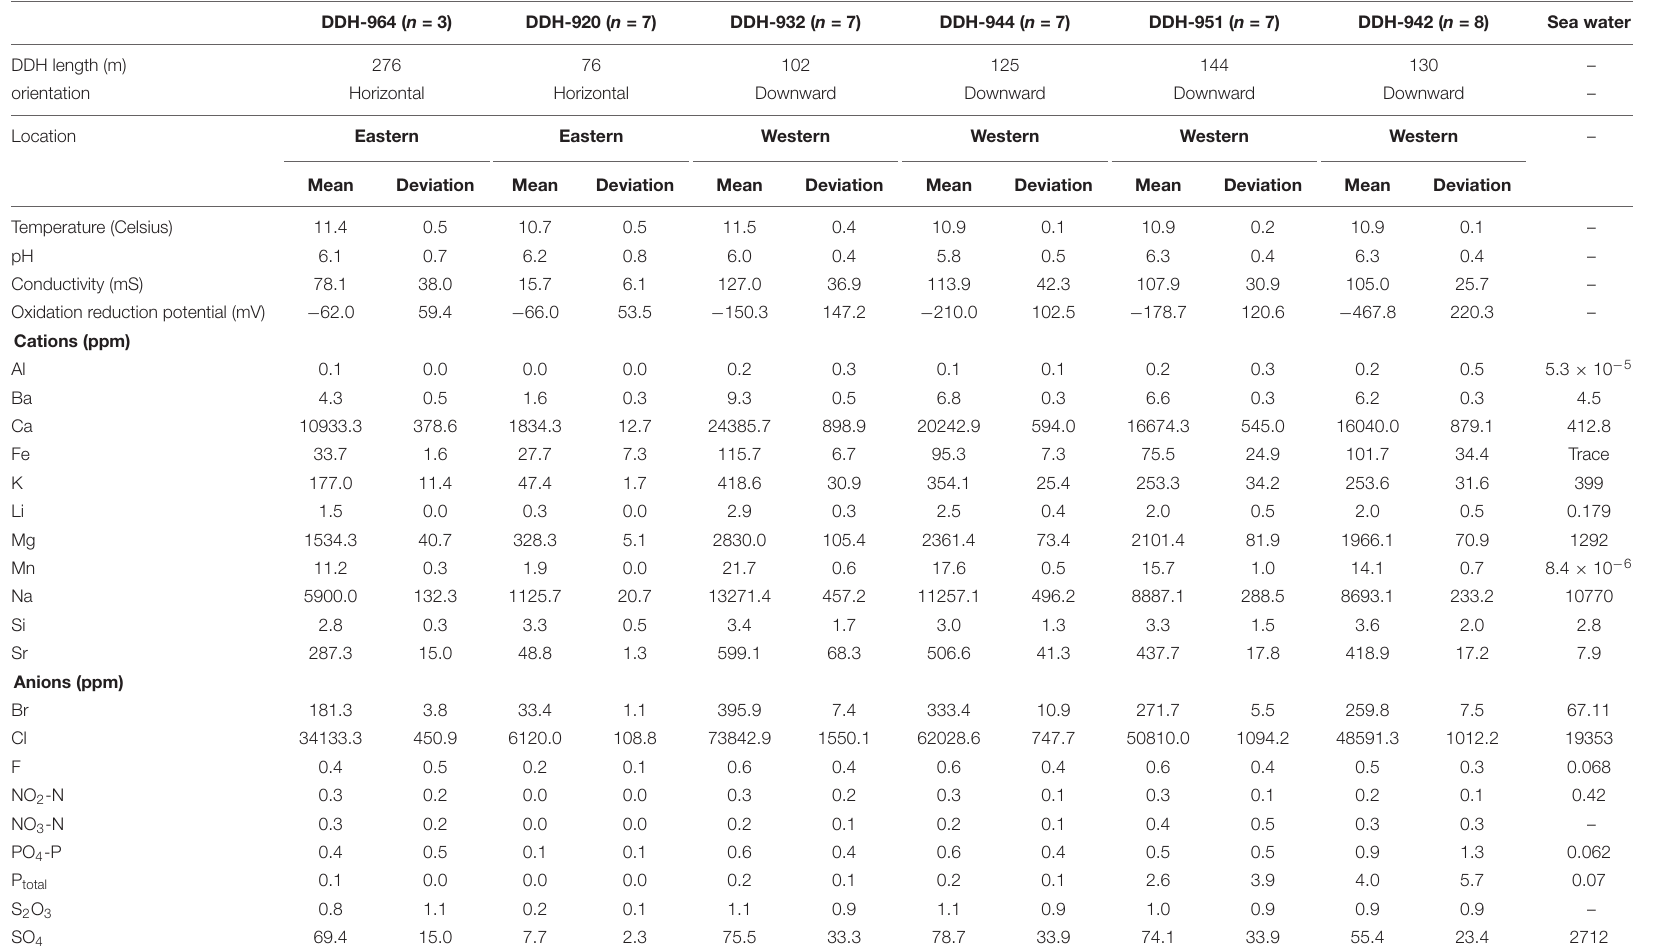
TABLE 1 | Summary of borehole water chemistry from the long-term